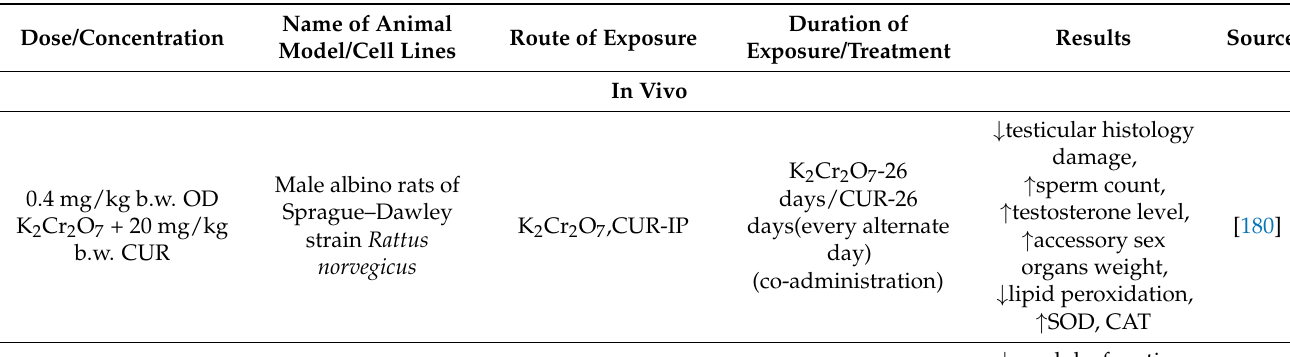
Table 11. Effects of curcumin on chromium toxicity based on doses, experimental methods, and